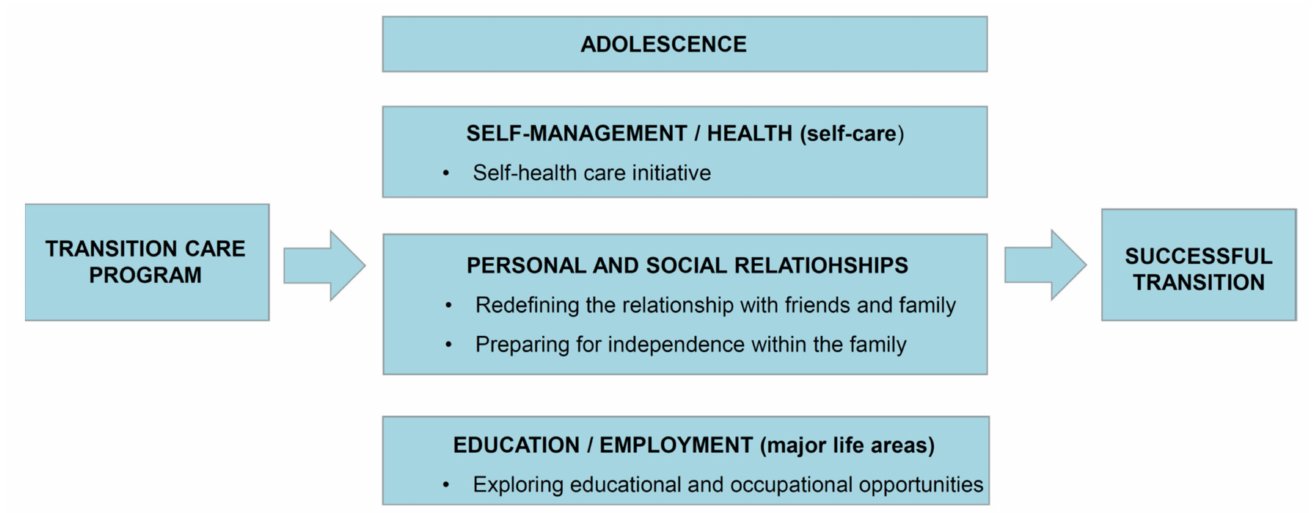
Figure 1. The framework of the transition care